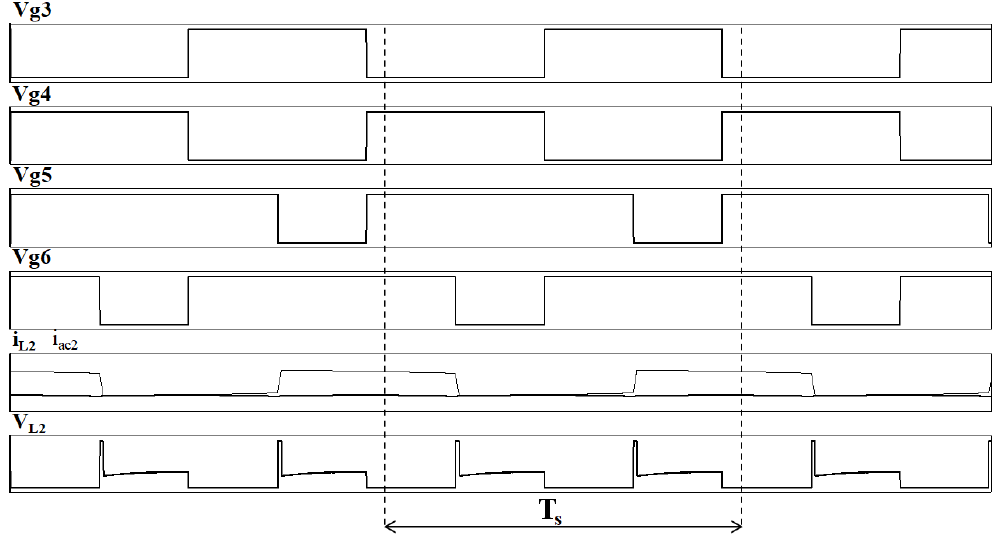
Figure 6. Secondary-side waveforms for the conventional PSM.